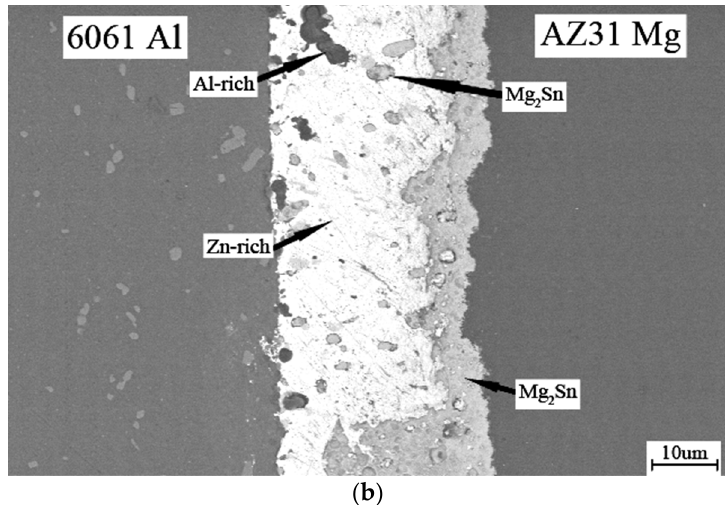
Figure 9. Cross-sectional SEM micrographs of the AZ31 magnesium/6061 aluminum alloy joints bonded with the Sn-5Zn-0.1RE filler metal after aging at 150 °C for. ( a ) 50 h; ( b ) 100 h